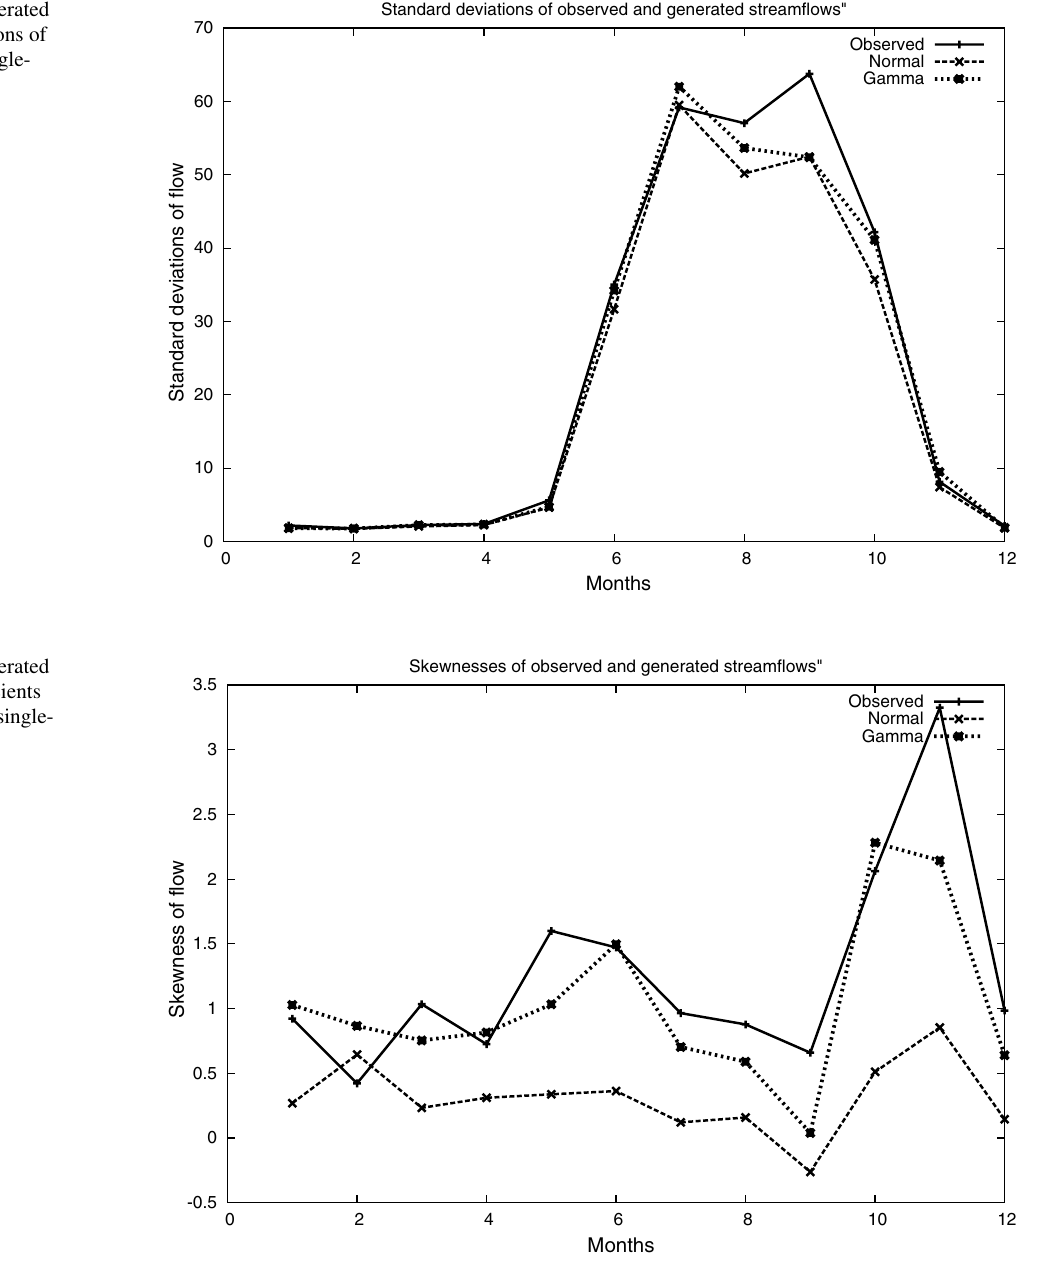
Fig. 4 Historical and generated monthly skewness coefficients of flows in Konar River (single- site